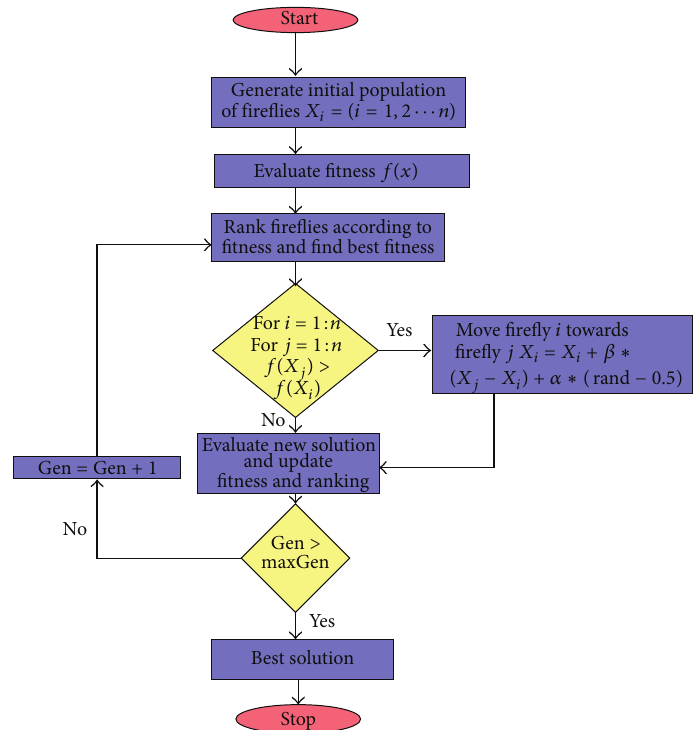
Figure 7: Flowchart of firefly algorithm.